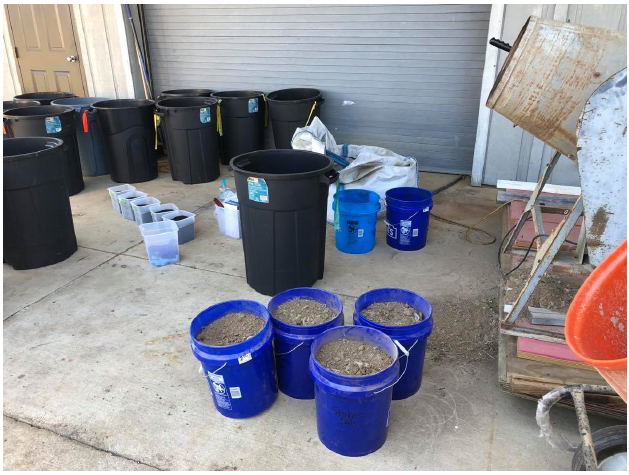
Figure 1. PL (blue buckets) were mixed with BC (clear containers) in a concrete mixer and transferred to perforated black 35-gallon containers. A sample from each replicate was taken at Day 0 and measured for moisture content.